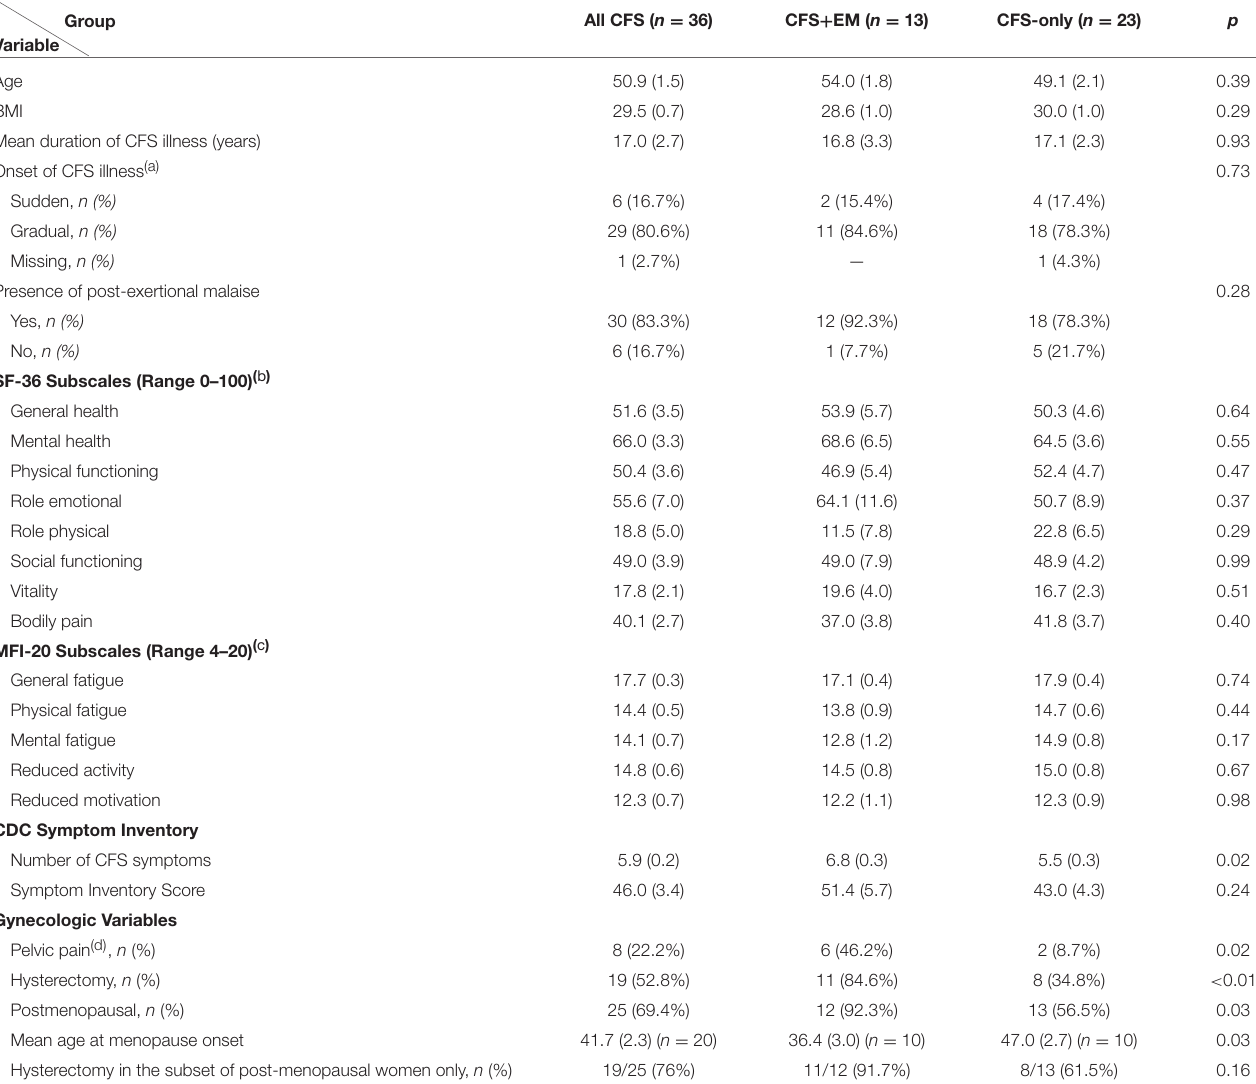
TABLE 2 | Comparison of select characteristics in women with CFS by subgroup—with and without endometriosis comorbidity.